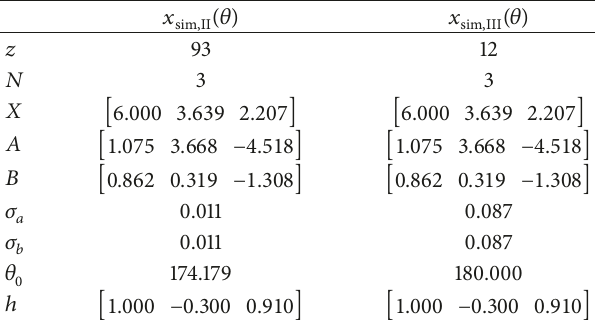
Table 1: Simulated signal